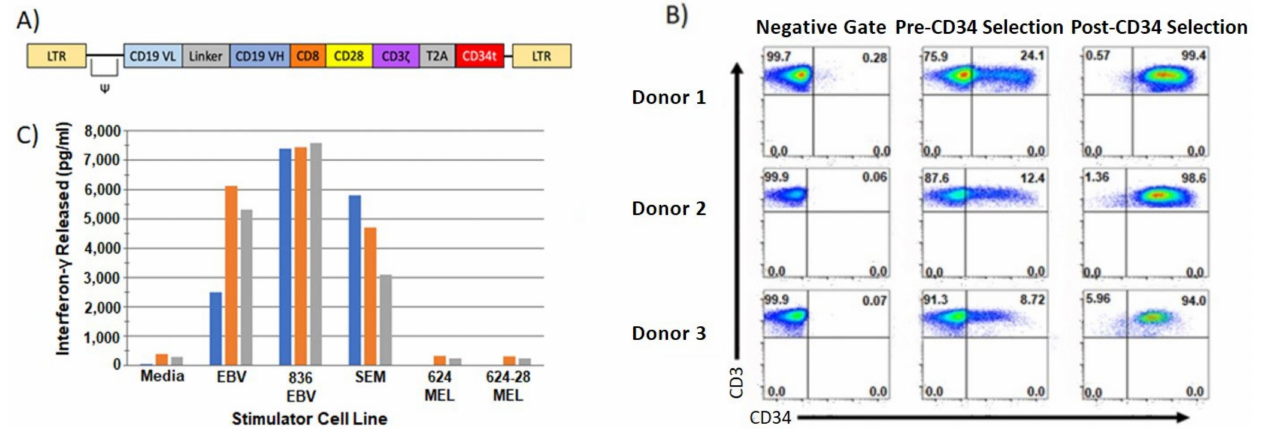
Figure 5. Transduction, expression, and function of CD19 transduced human T cells. We use retroviral and lentiviral vectors to engineer normal and cancer patient PBL-derived T cells to express TCR. ( A ) The general structure of our CD19 CAR retroviral vector is shown as follows: 5 (cid:48) LTR, the Ψ + packaging signal, the CD19 CAR which consists of CD19 V L fused to CD19 V h by a flexible linker followed by CD8 hinge then a CD28 cassette followed by CD3 ζ . The CAR is fused to a T2A self- cleavage peptide fused to the CD34t marker gene followed by the 3 (cid:48) LTR. ( B ) Expression of the CD19 CAR in PBL-derived T cells from 3 normal donors. CD19 CAR expression is based on the CD34 marker gene expression. Transduction efficiency of untransduced (Negative Gate), pre-CD34 selection, and post-CD34 selection is shown. Histograms represent CD3 expression (Y axis) and CD34 expression (X axis). ( C ) The amount of IFN- γ released by the CD19 CAR transduced T cells is shown. CD19 + stimulators include the line EBV, 836 EBV, and SEM and CD19 − stimulators include 624